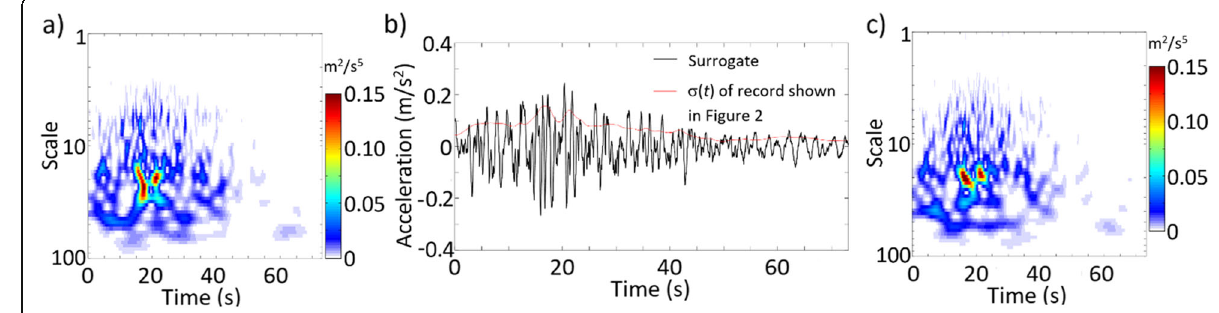
Fig. 4 Results by using WT for the given record shown in Fig. 2: a TSPSD of the given record, b a generated surrogate and σ ( t ) of the given record, and c TSPSD of the generated surrogate shown in Fig.